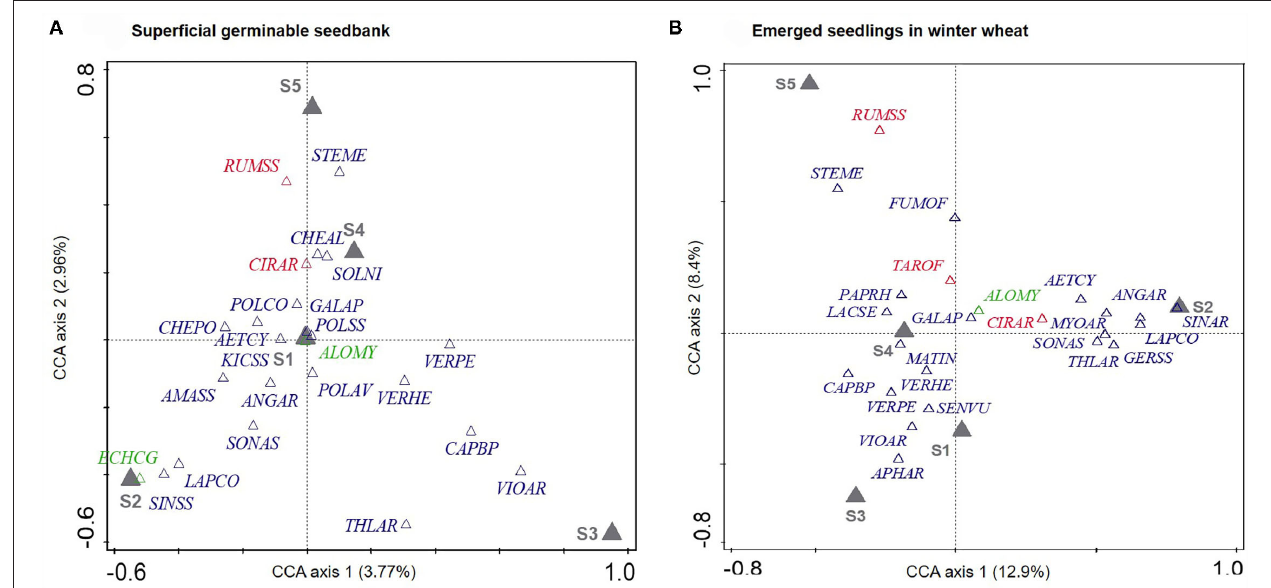
FIGURE 2 | Partial canonical correspondence analysis (pCCA) highlighting the effects of cropping systems (S1–S5) on community composition of the superficial germinable weed seedbank ( A , P -value = 0.002, explained variation = 9.4%) and in the subsequent winter wheat uniformity trial ( B , P -value = 0.002, explained variance = 22.3%) after partialling out the sampling events (A) and field (A,B) effects. Only the most frequent species ( N = 24, green: annual grass; blue: annual dicots, red: perennial dicots) are represented and named according to their EPPO codes